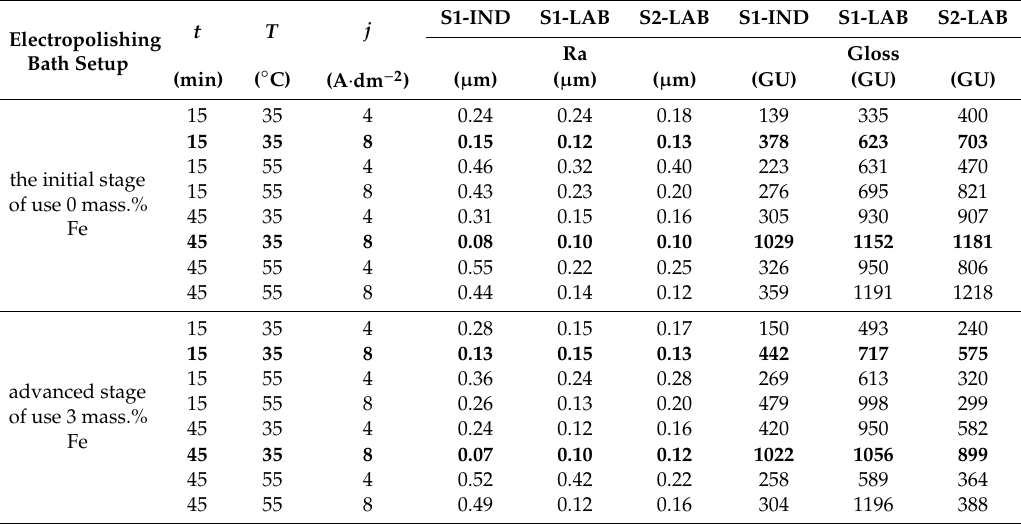
Table 1. Roughness average Ra and gloss results for samples after